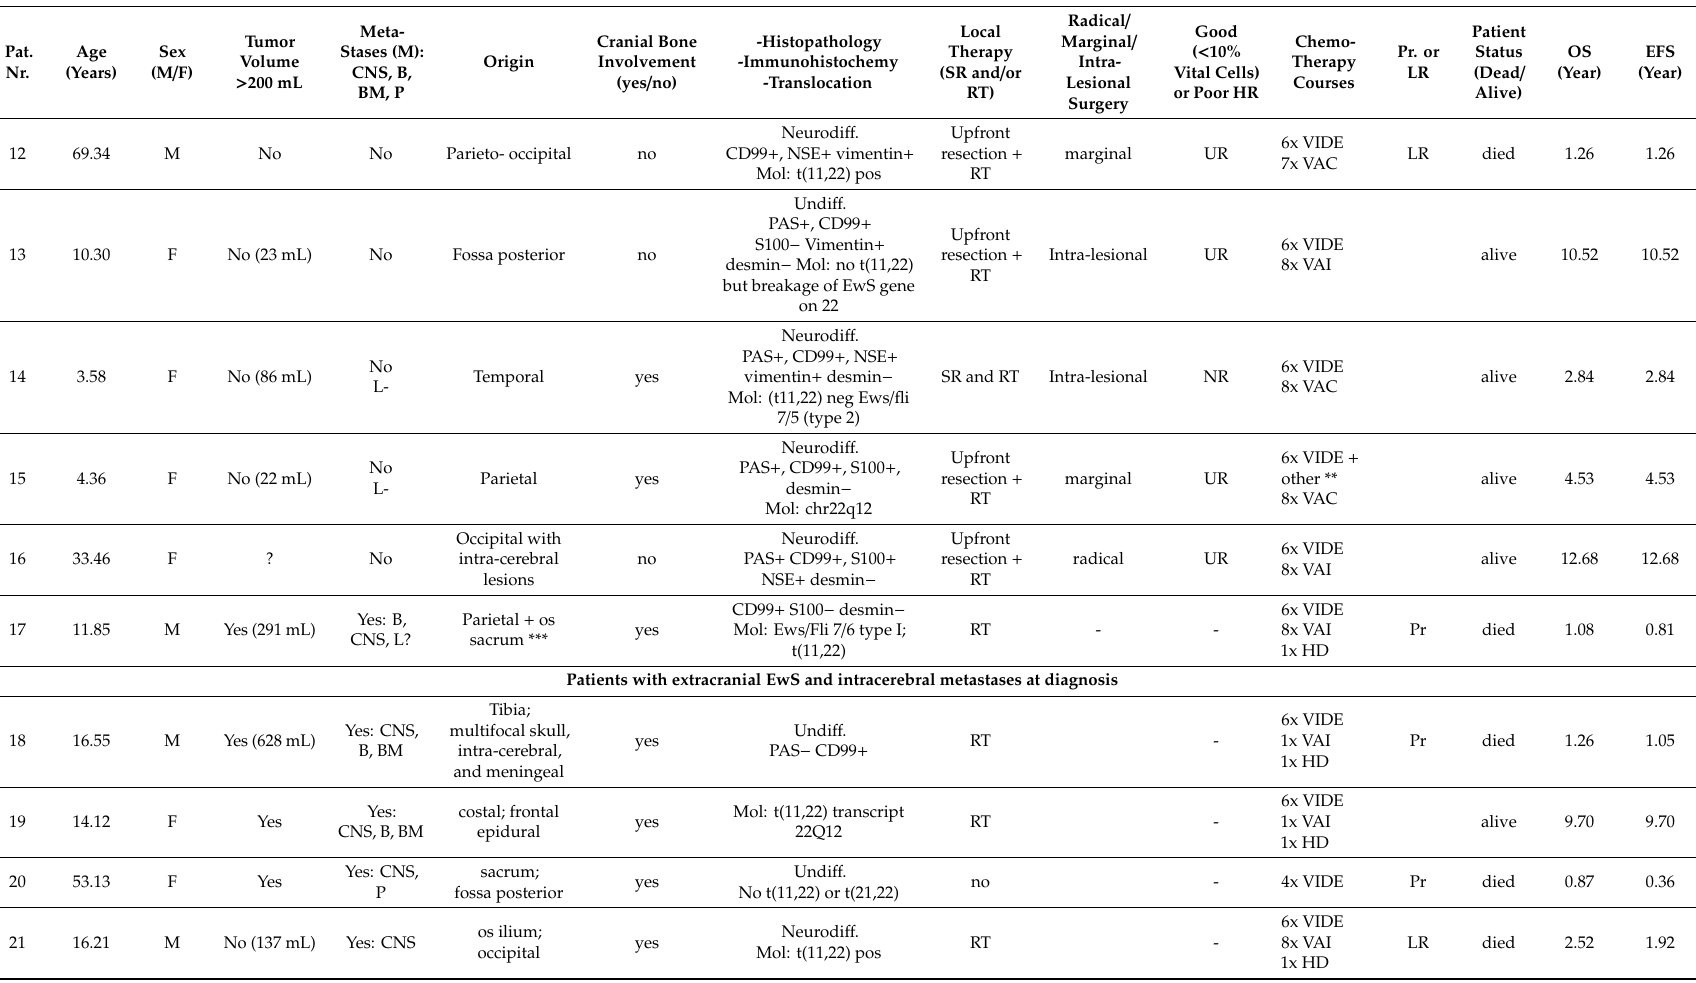
Table 2. Baseline characteristics and treatment modalities of included patients with primary and metastatic intracranial Ewing sarcoma.